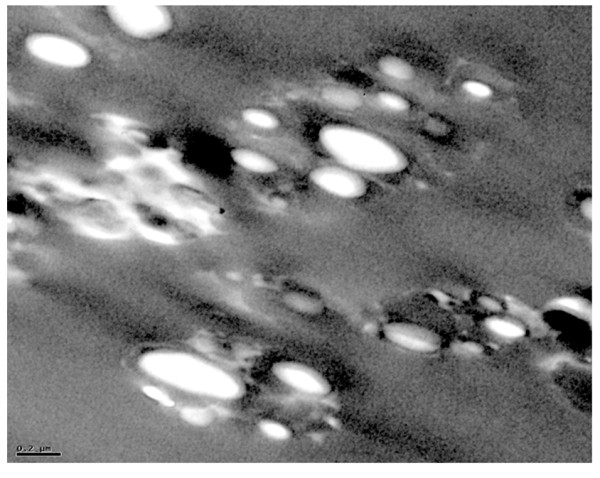
Transmission electron micrographs of PLA 208 oily core nanocapsules after freeze drying (F6). Scale bar represents 0.2 μm.